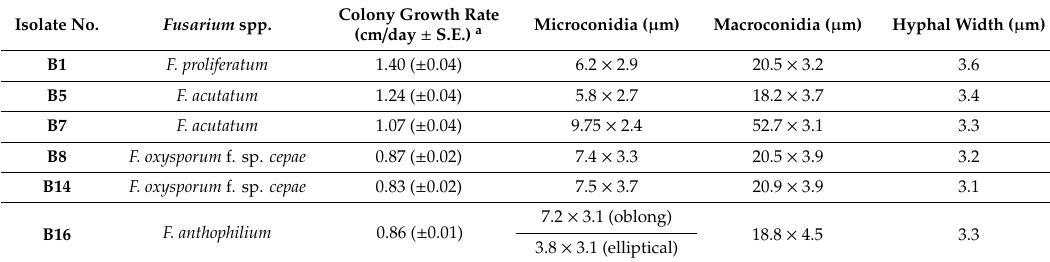
Table 3. Microscopic characterization and identification of Fusarium spp. isolates. Isolate No.